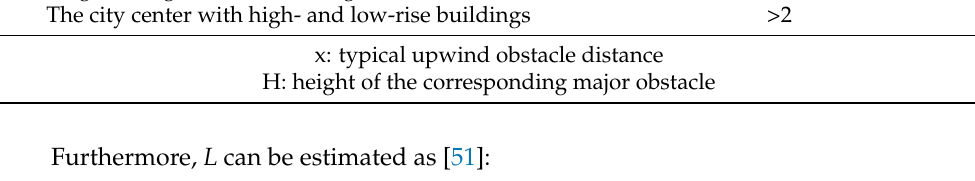
Table 5. Roughness length approximation based on terrain classification [49]. Terrain Classification z 0 (m) Open sea 0.0002 Mudflats, snow; no vegetation, no obstacles 0.005 Open flat terrain; grass, few isolated obstacles